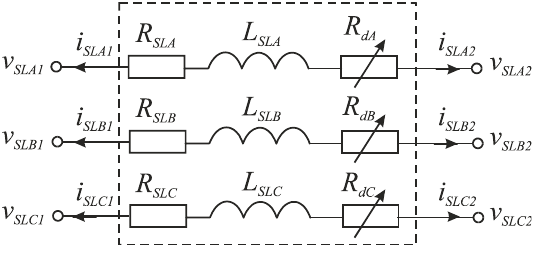
According to the approach used, a short network with furnace space (arc) is represented as six-pole (Figure 4) and is described by an external vector equation of the form (17), obtained on the basis of Equation (1).